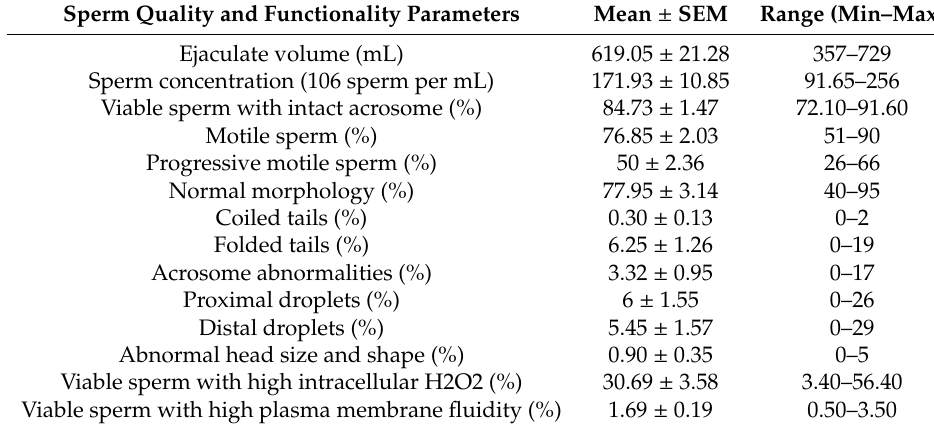
Table 1. Sperm quality and functionality parameters of pig semen samples assessed immediately after ejaculation ( n = 20).